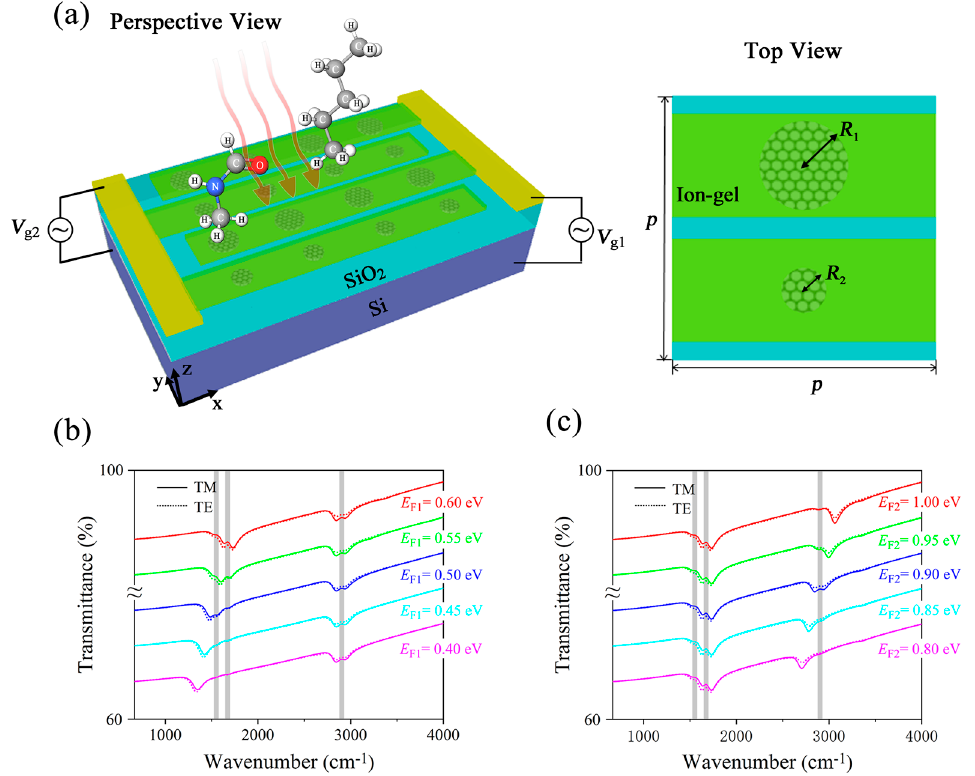
Figure 6. ( a ) Schematic of the MRGB consisting of periodic graphene nanodisks. R 1 and R 2 ( R 1 > R 2 ) are the radiuses of the bigger and smaller graphene nanodisk, respectively. ( b , c ) are the transmittance of 3D MRGB covered with protein and lipid molecules while sweeping E F 1 ( b ) and E F 2 ( c ) of graphene under normal TM (solid curves) and TE (dashed curves) incidence. Gray vertical bars represent vibrational bands of protein and lipid molecules. Curve with larger E F is translated upward with 6% in order to demonstrate the spectral shift clearly.